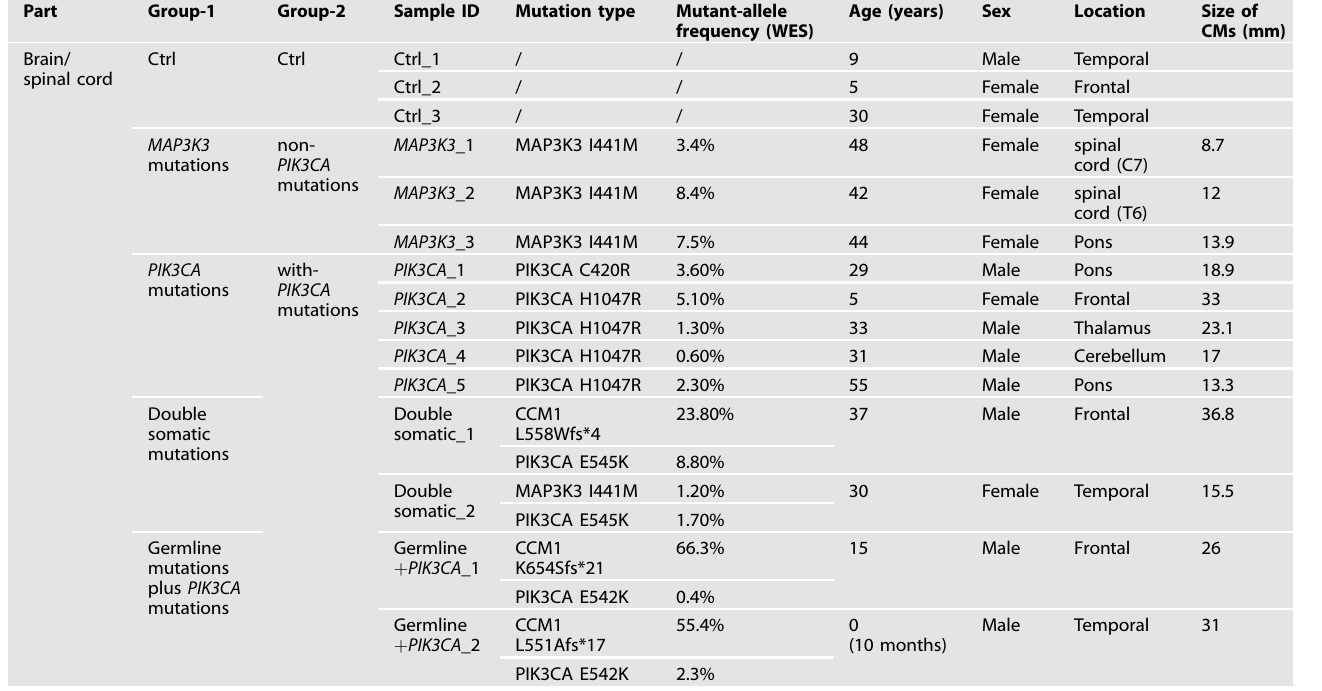
Table 1. Clinical characteristics and genotype of